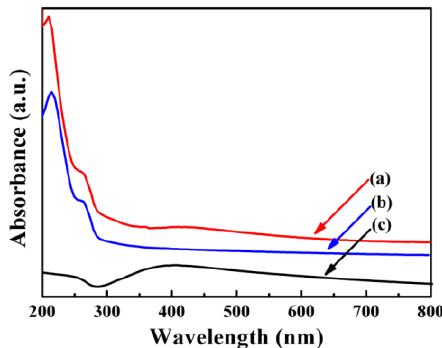
Figure5. UV–visabsorbancespectraof( a )Fe 3 O 4 / Ag / POMsnanocomposites, ( b )POMsand( c )Fe 3 O 4 / Ag Figure 5. UV–vis absorbance spectra of ( a ) Fe 3 O 4 /Ag/POMs nanocomposites, ( b ) POMs and ( c ) nanoparticles dispersed in H 2 Fe 3 O 4 /Ag nanoparticles dispersed in H 2 O.